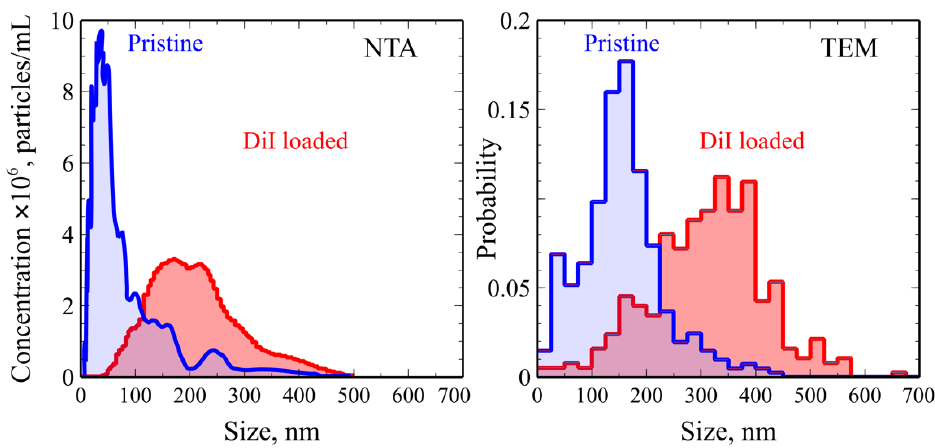
Figure 5. Size distribution of PVP-OD nanocarriers in DI water obtained from nanoparticle tracking analysis (NTA, left) and image analysis of TEM micrographs (TEM, right) for pristine aggregates of 6 kDa PVP-OD oligomers and PVP-OD aggregates loaded with DiI. The average number of particles per frame in NTA analysis was 44 and 41 for empty aggregates and the aggregates containing DiI, respectively. For image analysis, 407 pristine aggregates and 374 DiI-loaded aggregates were measured.